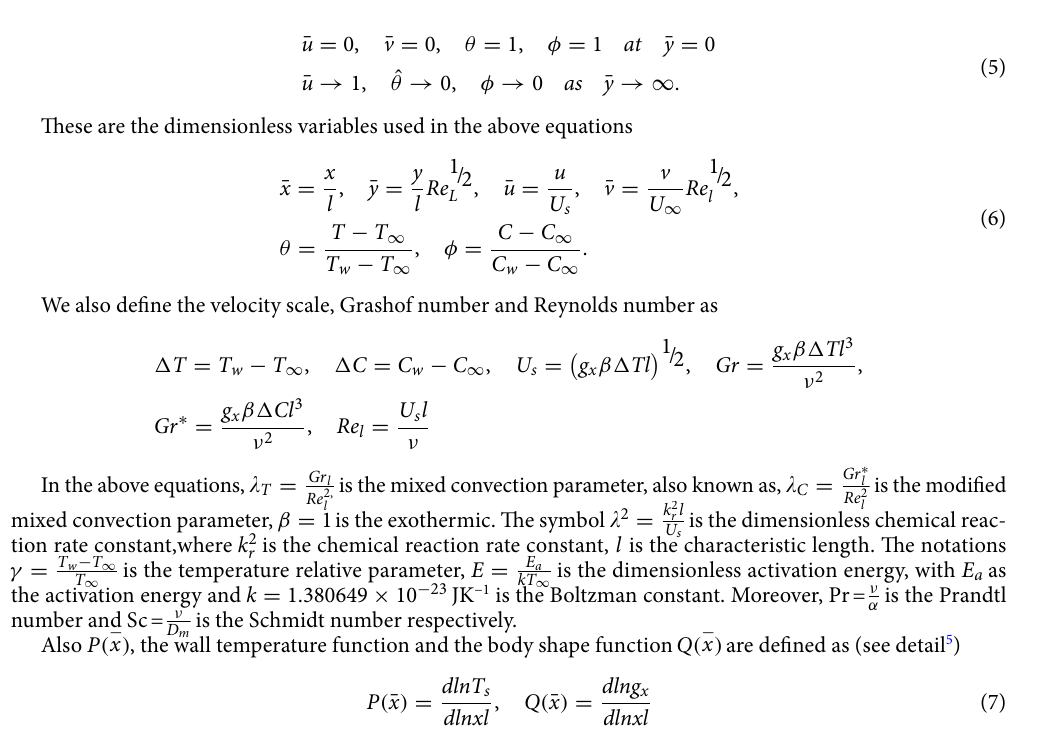
Figure 1. Coordinate system and flow configuration of the proposed